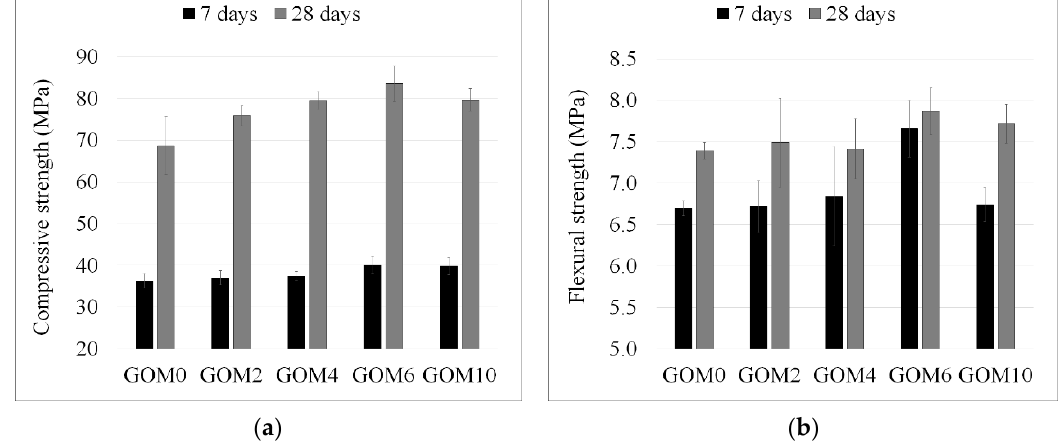
Figure 8. Compressive ( a ) and flexural ( b ) strength of mortars cured for 7 and 28 days,